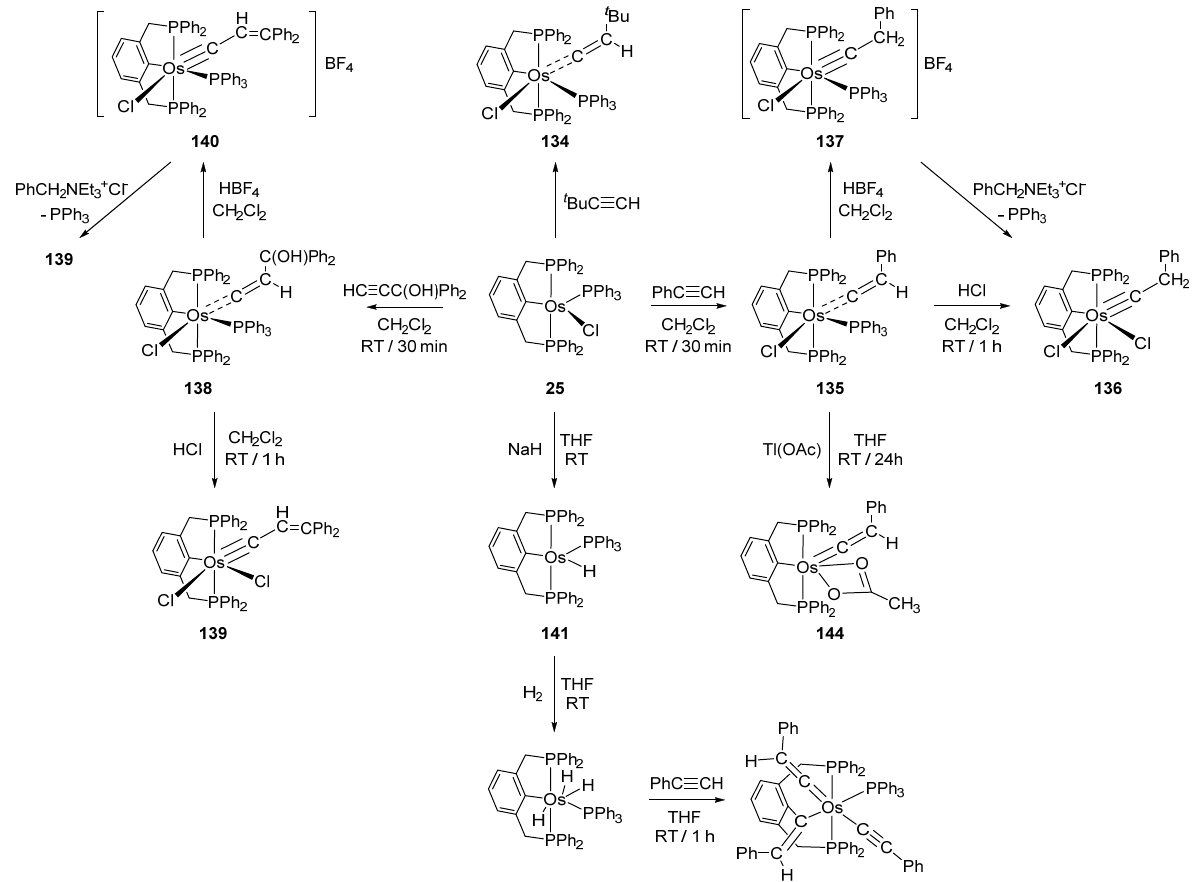
Figure 30. Reactions between osmium P~C~P pincer complex 25 with alkynes. Related P~C~P pincer complex 26 reacts with H 2 giving rise to dihydride species 145 . Carbonyl derivatives 146 and 147 can also be prepared in the presence of CO (Figure 31) [41]. Figure 31. Reactions of P~C~P pincer complex 26 with H 2 and CO.